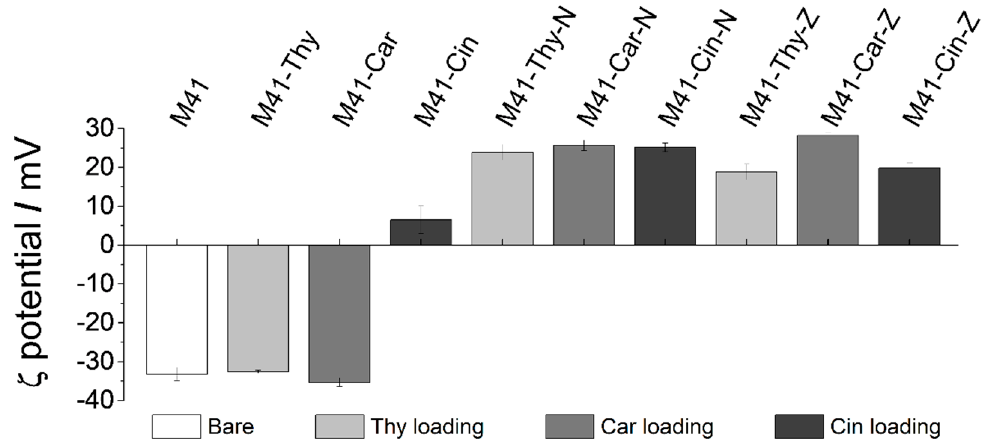
Figure 3. ζ potential values of the solids in the different synthesis steps.